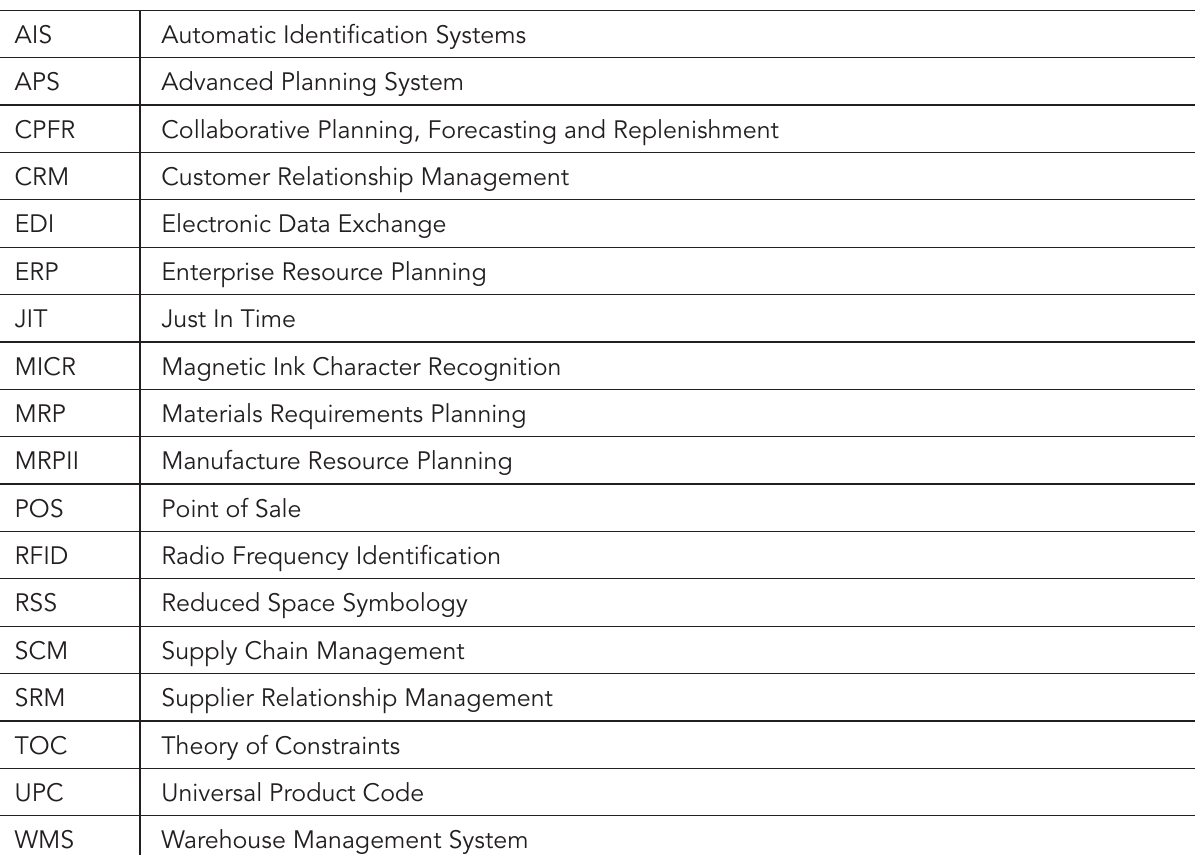
AIS Automatic Identification Systems